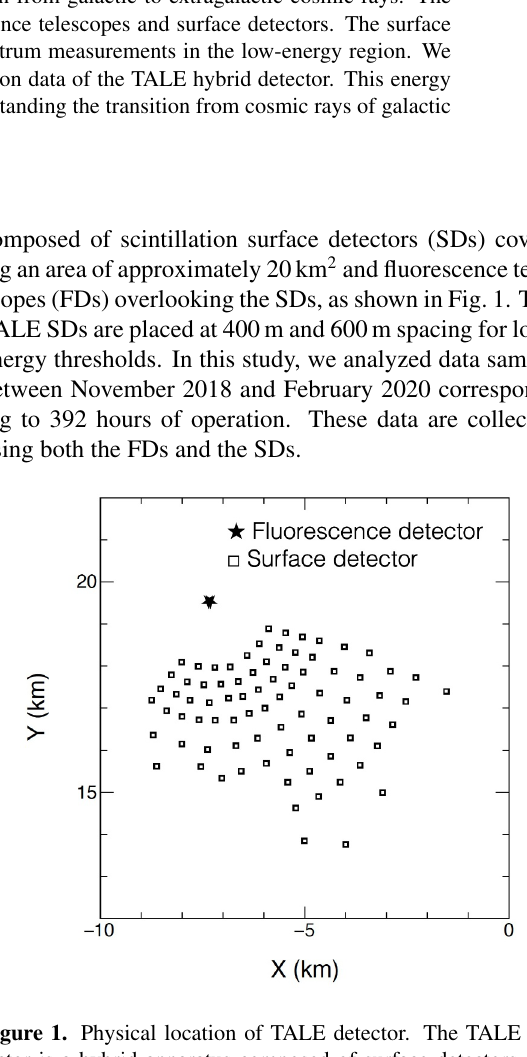
Figure 1. Physical location of TALE detector. The TALE de- tector is a hybrid apparatus composed of surface detectors and fluorescence